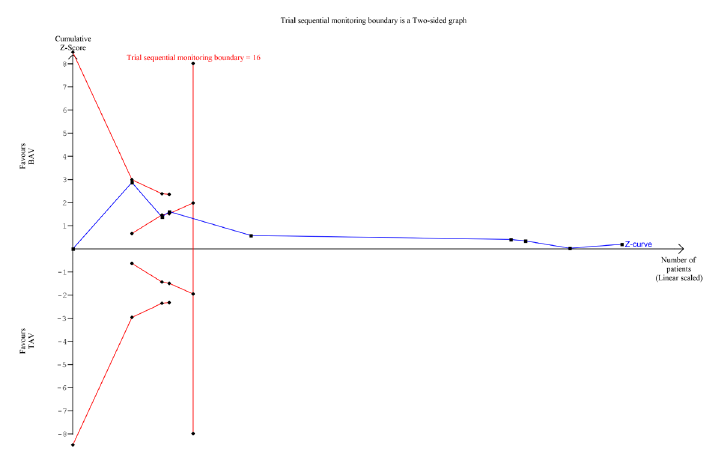
Fig. 8 - Trial sequential analysis diagram for 1-year mortality. BAV=bicuspid aortic valve; TAV=tricuspid aortic valve